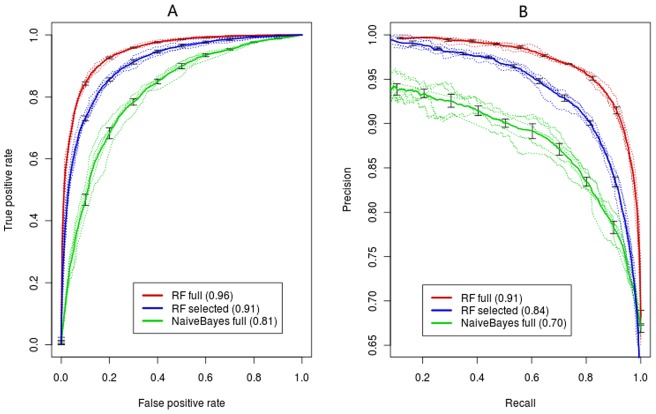
ROCs and precision-recall curves for Naïve Bayes (green) and random forest (red) with full and selected features.(A) ROCs (B) precision-recall curves.